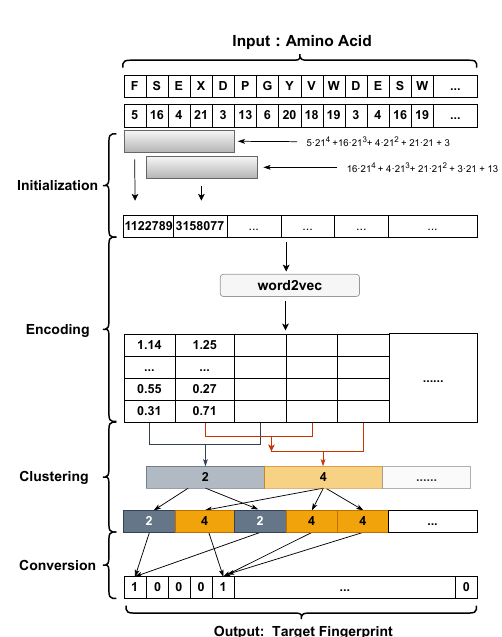
Fig. 2 Procedures for target fingerprint generation. The source amino acid sequence is encoded into the target